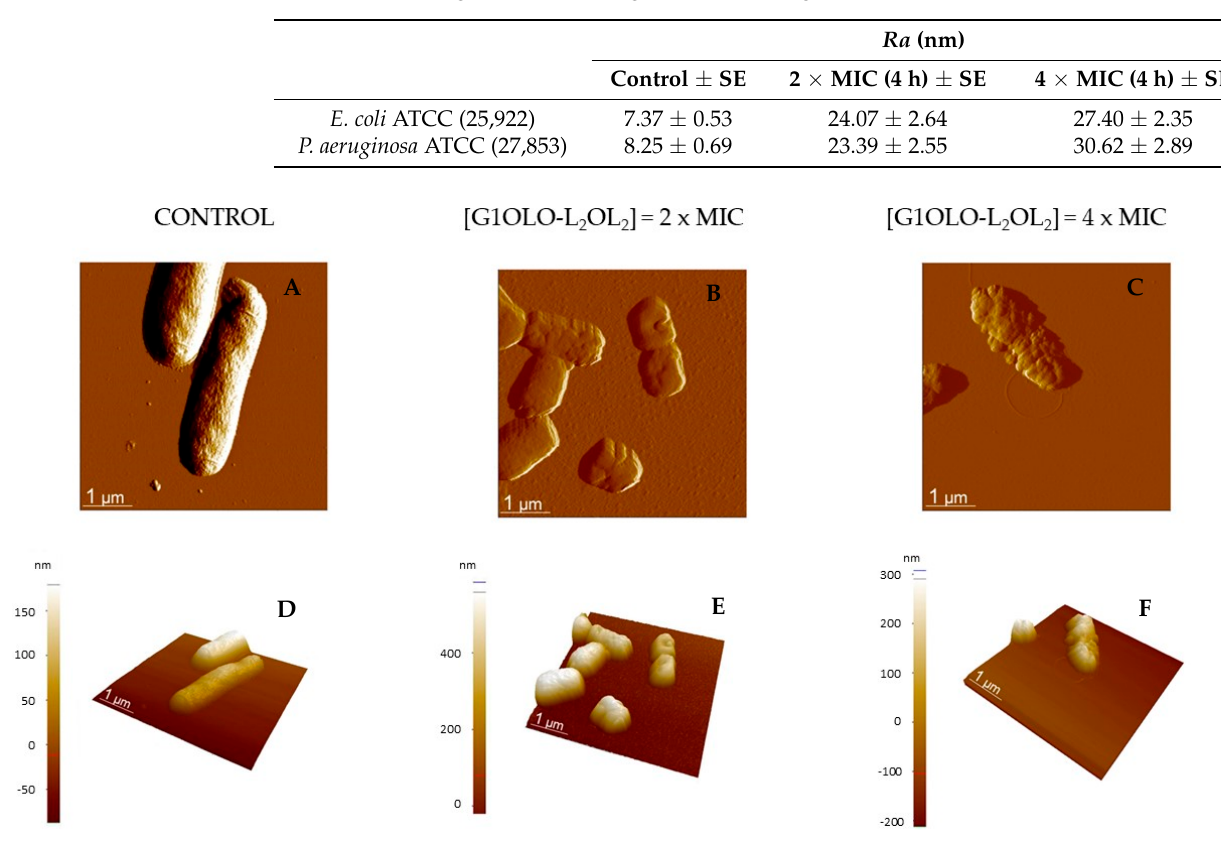
Figure 6. AFM amplitude ( A – C ) and 3D topographic images ( D – F ) of P. aeruginosa (27,853) incubated with different concentrations of the peptide G1OLO-L 2 OL 2 . Table 4. Nano-roughness ( Ra ) average values from Figures 6 and 7.